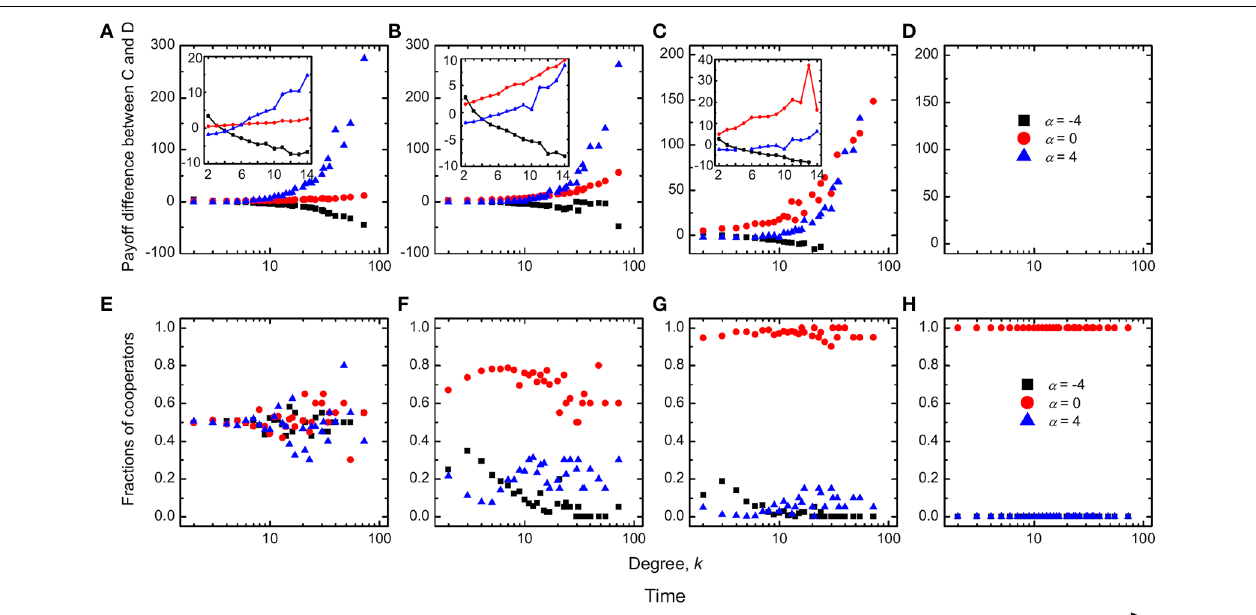
FIGURE 5 | Time evolution of the mean payoff difference between cooperators and defectors (A–D) and the fraction of cooperators (E–H) as a function of degree k for three typical values of α . Institutional punishment and absolute payoffs apply. The insets of (A,B) show the mean payoff difference between cooperators and defectors